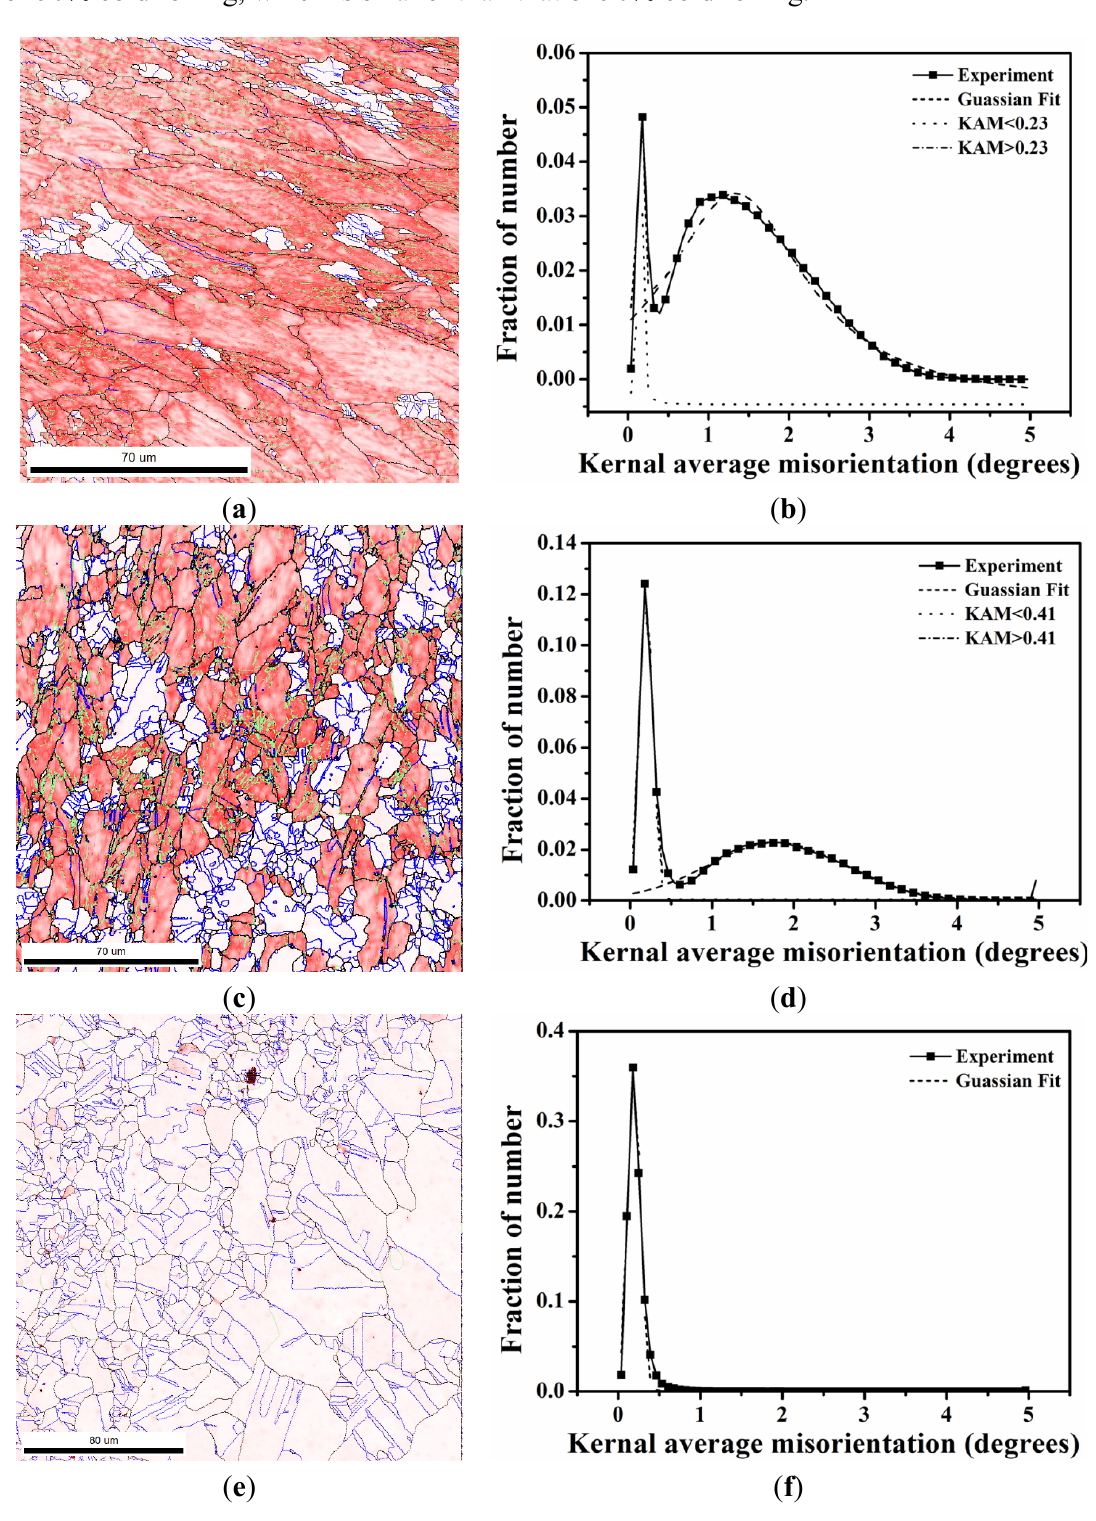
Figure 1. KAM maps after ( a ) 1 min; ( c ) 2 min; and ( e ) 48 h and KAM histogram after ( b ) 1 min; ( d ) 2 min; and ( f ) 48 h for 50% cold-rolled FePd alloy at 700 °C. (The KAM value ranges from 0° to 5°, corresponding to white and red. LAGB: Green, HAGB: Black and CSL: